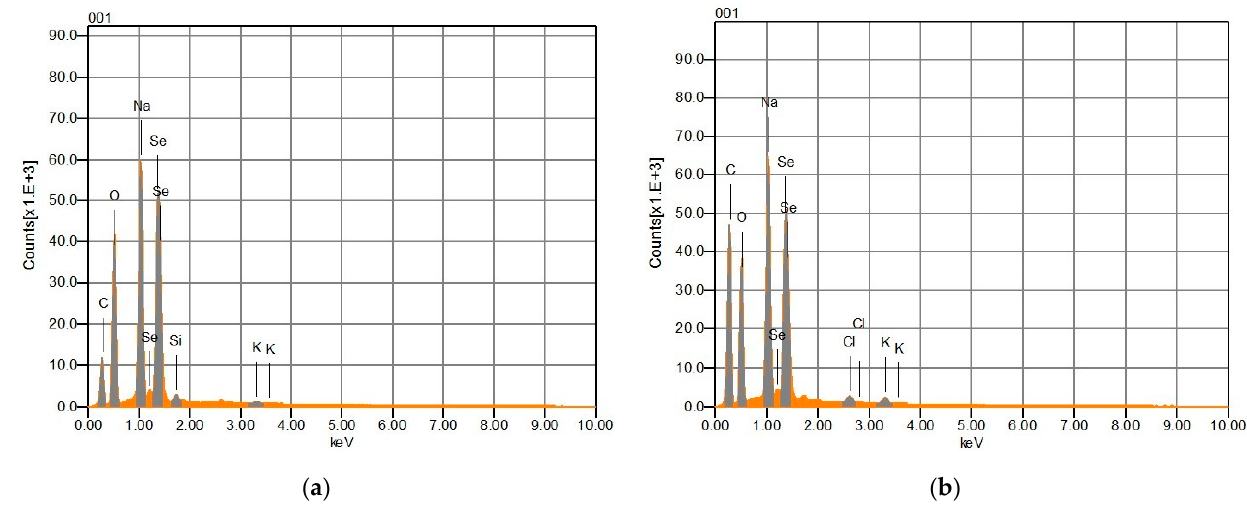
Figure 3. EDS analysis of the elemental composition of selenium nanoparticles (SeNPs) obtained via green synthesis. ( a ) SeNPs-AGL synthesized with extracts of A. glaucum leaves. ( b ) SeNPs-COF synthesized with C. officinalis flower extracts. Table 3. Elemental composition via Litesizer of the selenium nanoparticles (SeNPs) synthesized with extracts of A. glaucum (SeNPs-AGL) and C. officinalis